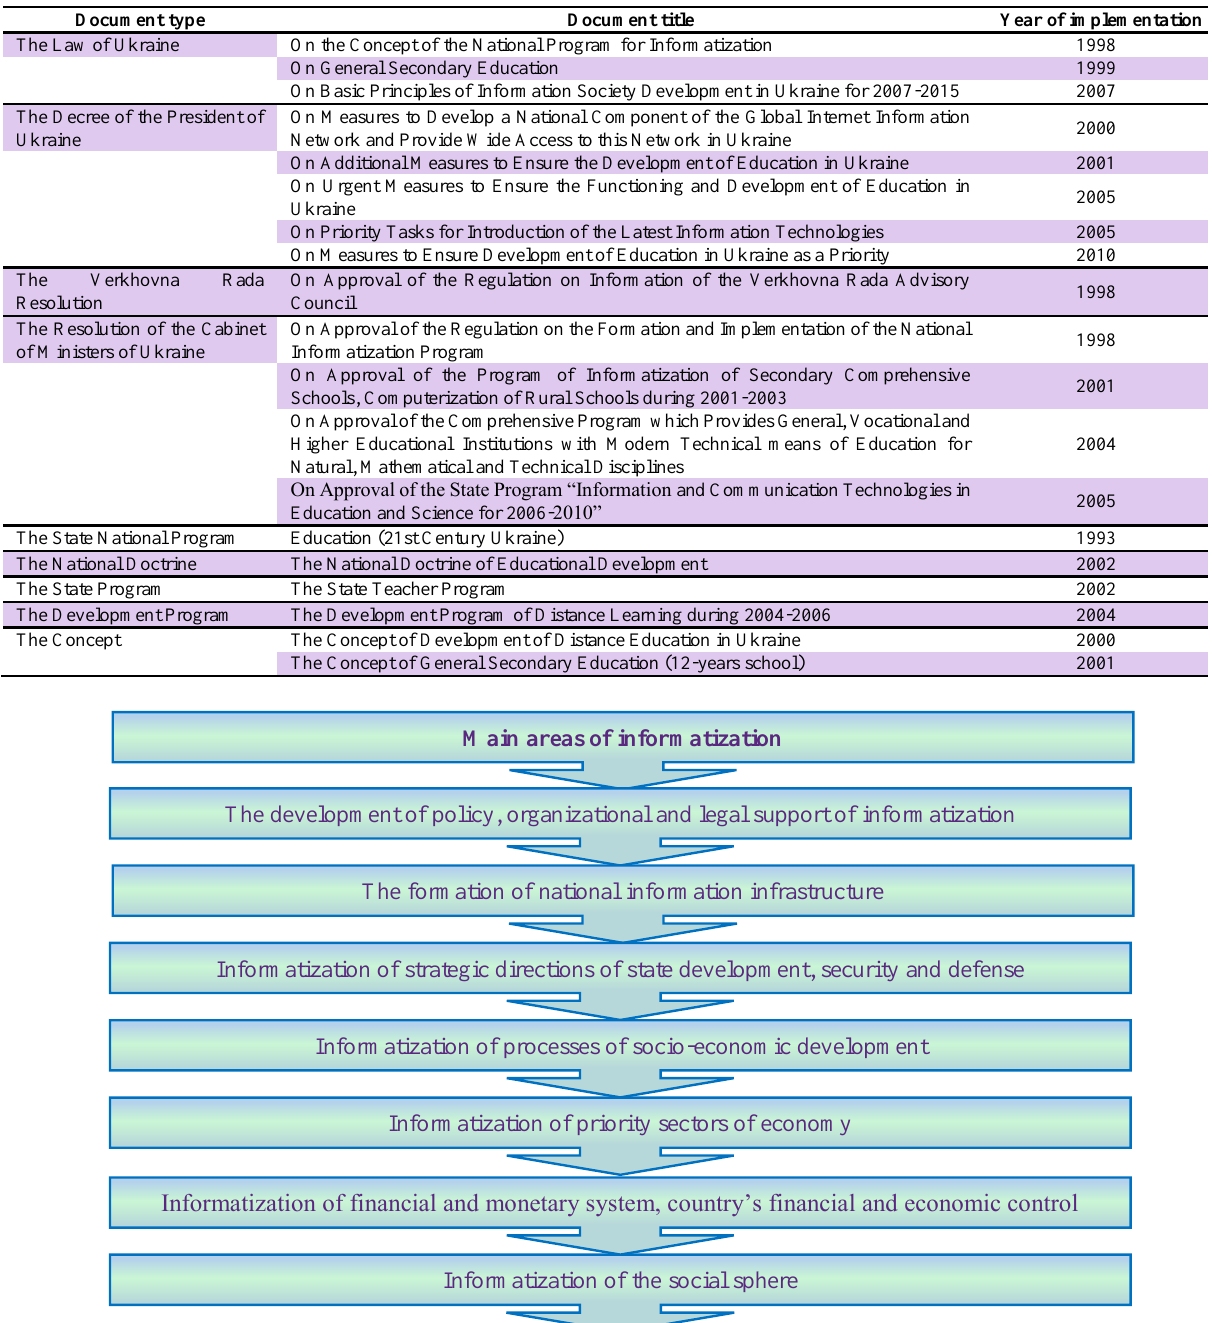
Table 1. The list of the most significant legislative documents on creation an information society in the country on the basis of inclusive informatization.